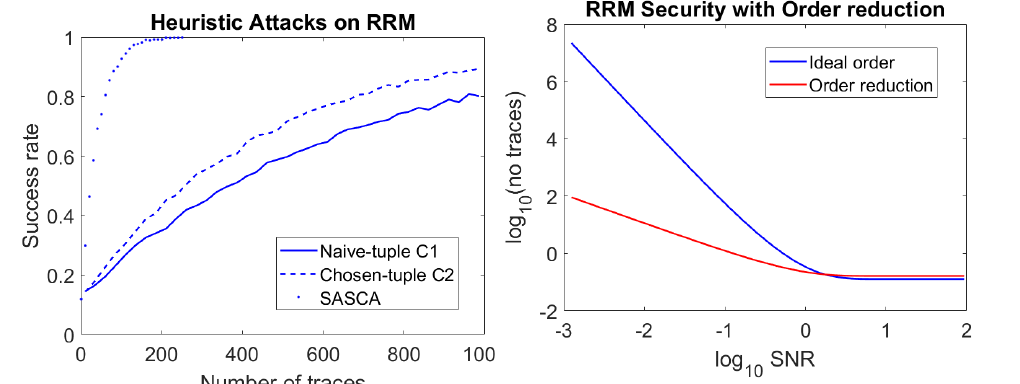
Figure 6: Practical attacks and realistic leakage